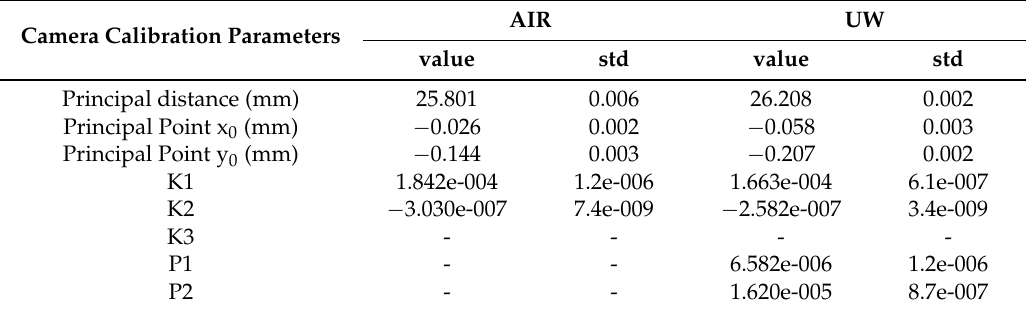
Figure 13. Test-field used in the swimming pool: ( a ) overall view of the complete board with stands; ( b ) part of the board used for the camera calibration. Table 6. Comparison between camera calibration in water (UW) and in air. Some non-significant additional parameters were not computed during the self-calibration